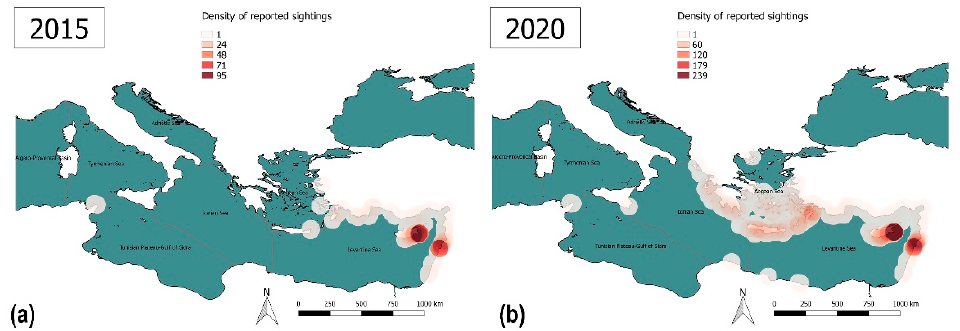
Figure 2. Heat map of the density of the reported lionfish sightings in the literature and authors’ datasets (radius = 70 km) in ( a ) 2015 and ( b ) 2020 (the dataset is available in Supplementary Material 2).